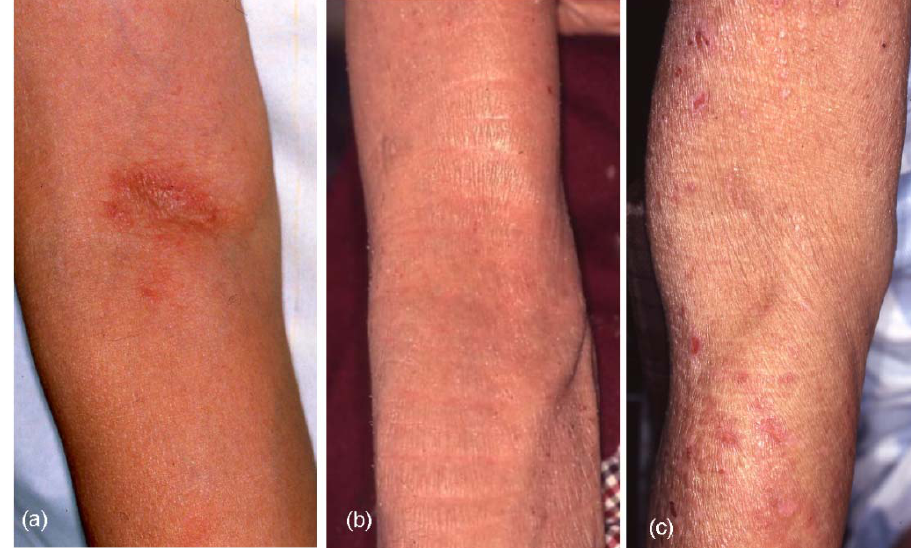
Figure 4. Skin manifestations of elderly patients with atopic eczema (AE). ( a ) Facial eczematous erythema (atopic red face) with Hertoghe’s sign (loss of lateral eyebrows); ( b ) Diffuse eczematous erythema and papules on the neck and upper back; ( c ) Lichenified eczema of erythroderma on the trunk; ( d ) Nummular-form eczema with acute inflammation on the back; ( e ) Nummular-form eczema changed to exudative inflammatory erythema after 1 week; ( f ) Prurigo-forming papules and nodules on the upper extremities and trunk.